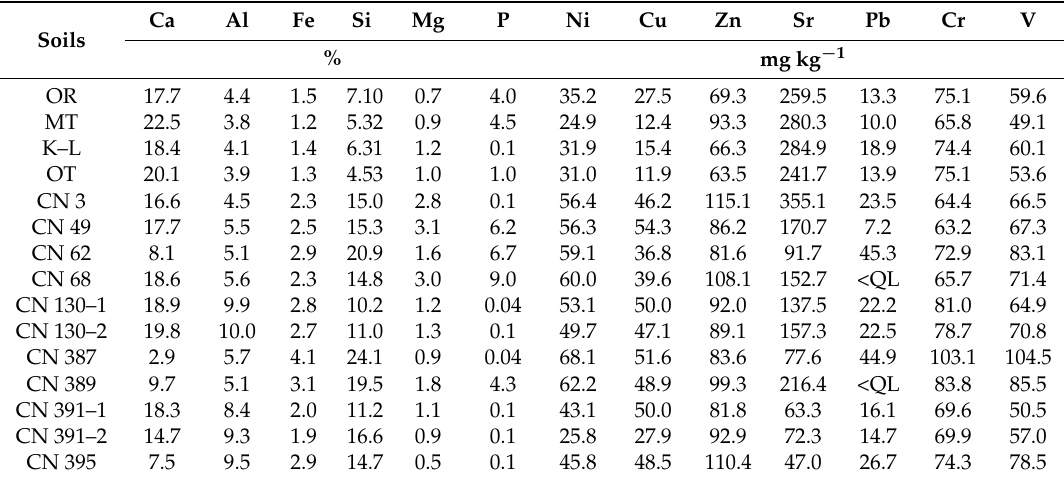
Table 1. Geochemical features in horizon A of post-antique long-fallow lands under vineyards of ancient time on the near (CN) and distant (OR, MT, K–L, OT) chora Chersonesos. Soils